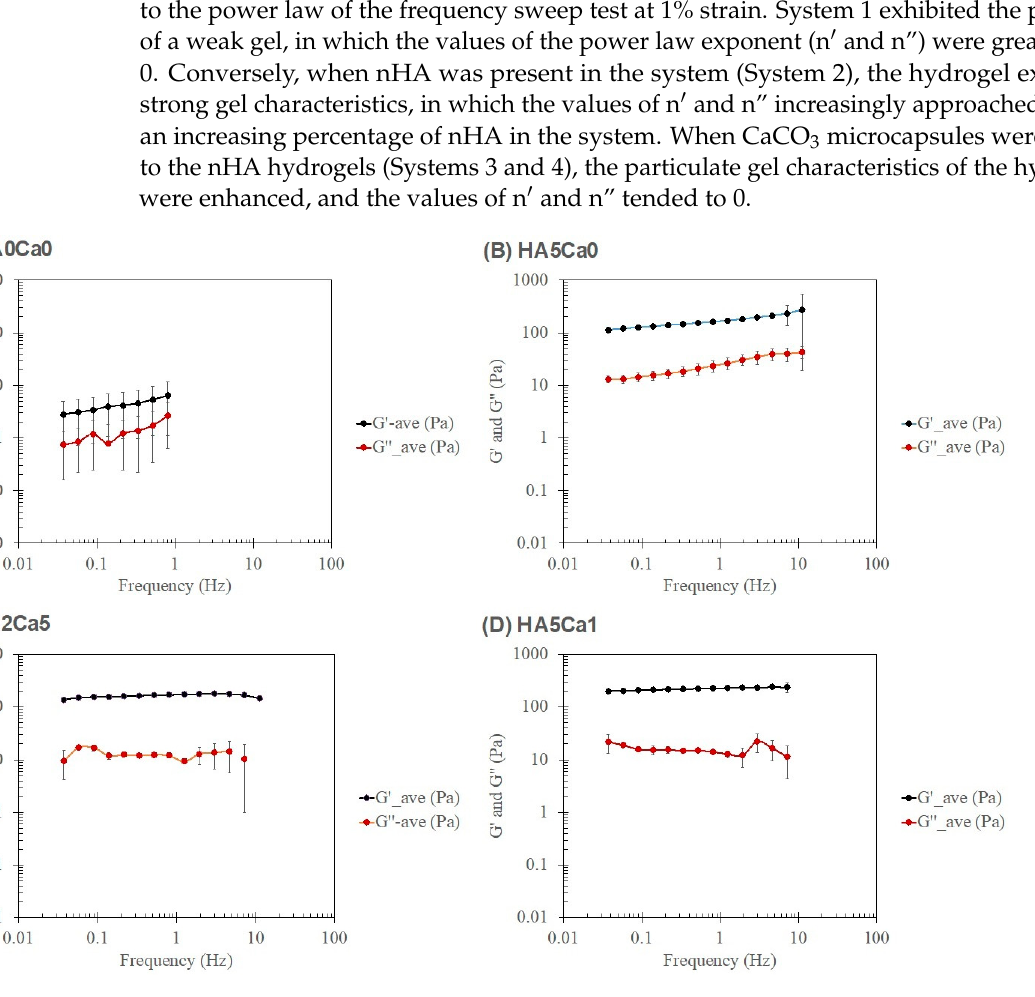
Figure 7. Frequency dependence of four systems: ( A ) System 1: chitosan/collagen hydrogel alone; ( B ) System 2: hydrogel with 5% nHA; ( C ) System 3: hydrogel with 2% nHA and 5% CaCO 3 ; and ( D ) System 4: the hydrogel with 5% nHA and 1% CaCO 3. Table 2. Rheological parameters of the power law model for the frequency sweep test at 1% strain and types of hydrogels.